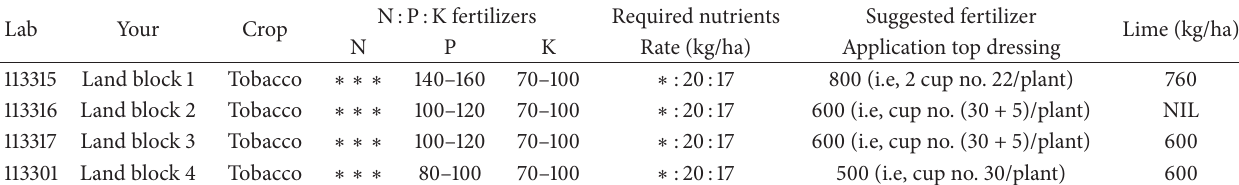
Table 1: Soil analysis and fertilizer recommendations for experimental plots.